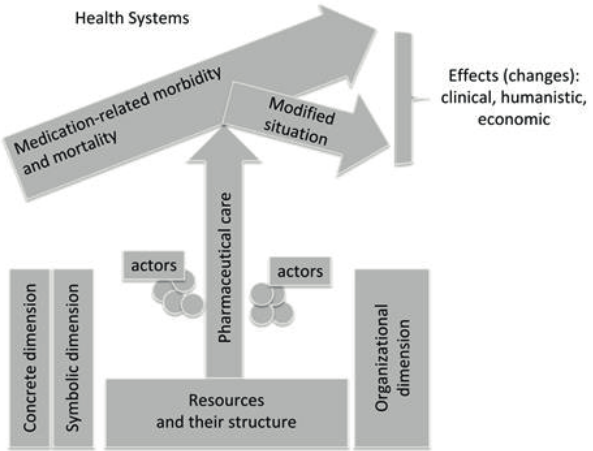
FIGURE 1 - Pharmaceutical care as an intervention (organized system of